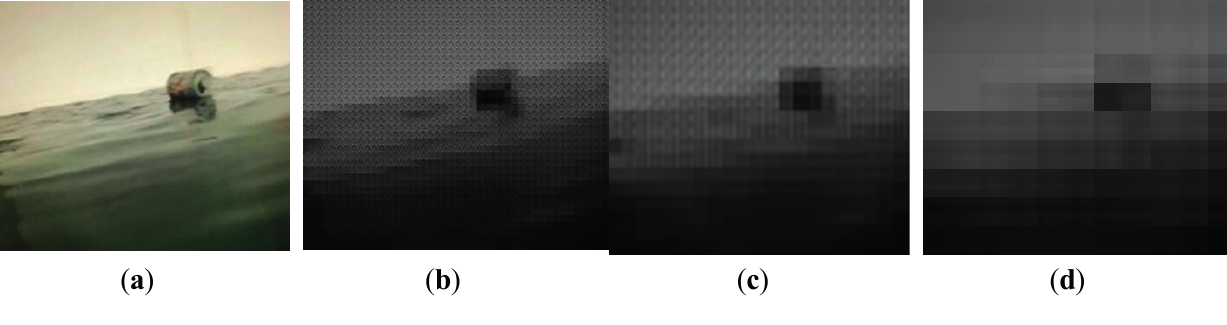
Figure 6. Image reconstruction under different block sizes. ( a ) Original frame of size 352 × 288; ( b – d ) denote reconstruction frames with the block of size 8 × 8, 16 × 16, 32× 32,